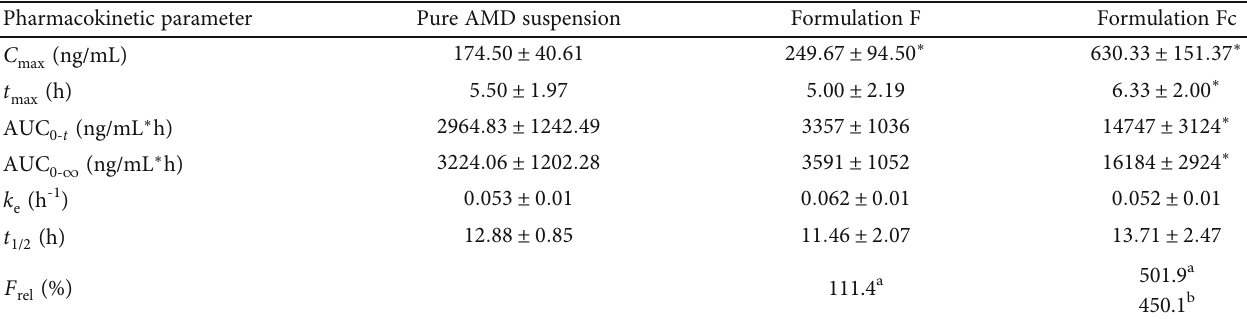
Table 10: Pharmacokinetic parameters of pure AMD suspension and F and Fc0 formulations in Wistar rats following single-dose oral administration ( mean ± SD , n = 6